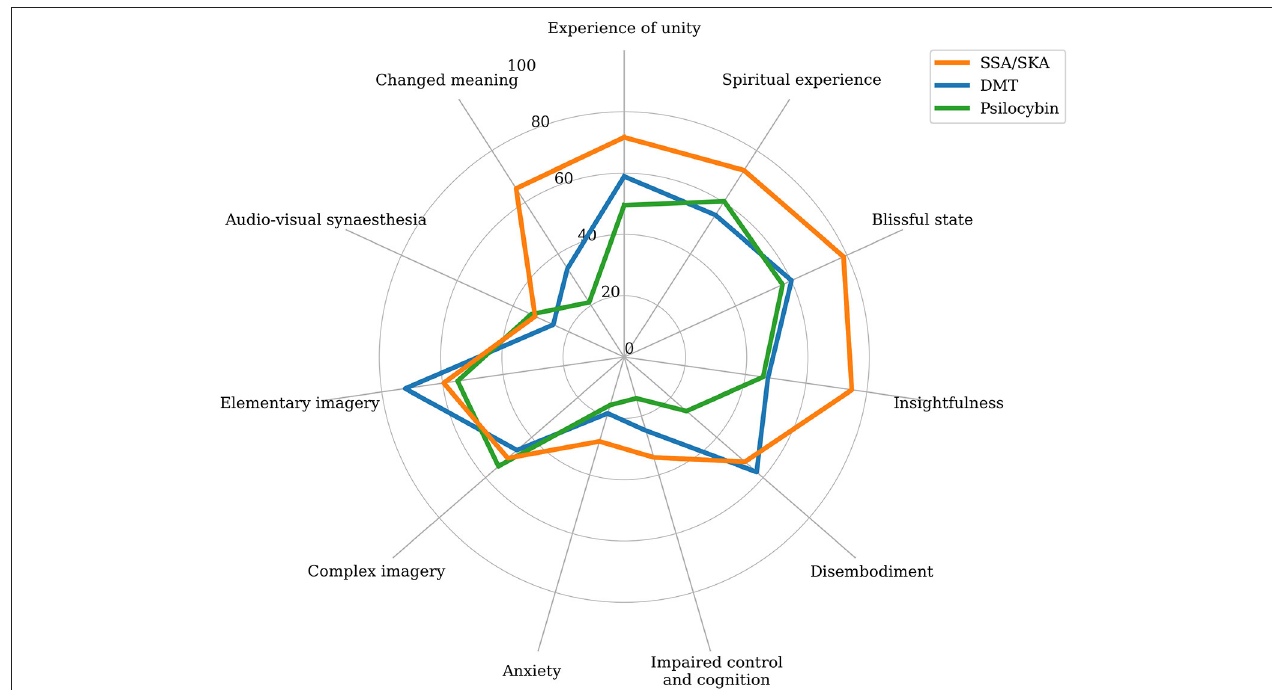
FIGURE 4 | Radar chart comparing the mean subscale scores of the 11-Dimensional Altered States of Consciousness Rating Scale (11D-ASC; Studerus et al., 2010) for the participants of this study (SSA/SKA; N = 152) and for drug induced altered states of consciousness (ASCs) produced by high dose psilocybin (Psilocybin; 30 mg/70kg; N = 20; Carbonaro et al., 2018); and high dose N,N- dimethyltryptamine (DMT; 40–75mg; N = 35; Luke, 2019).